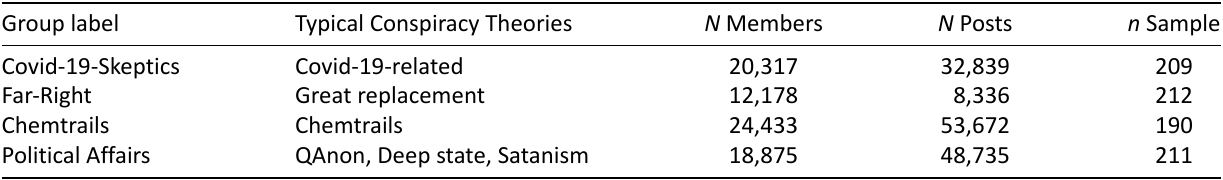
Table 1. Examined Facebook